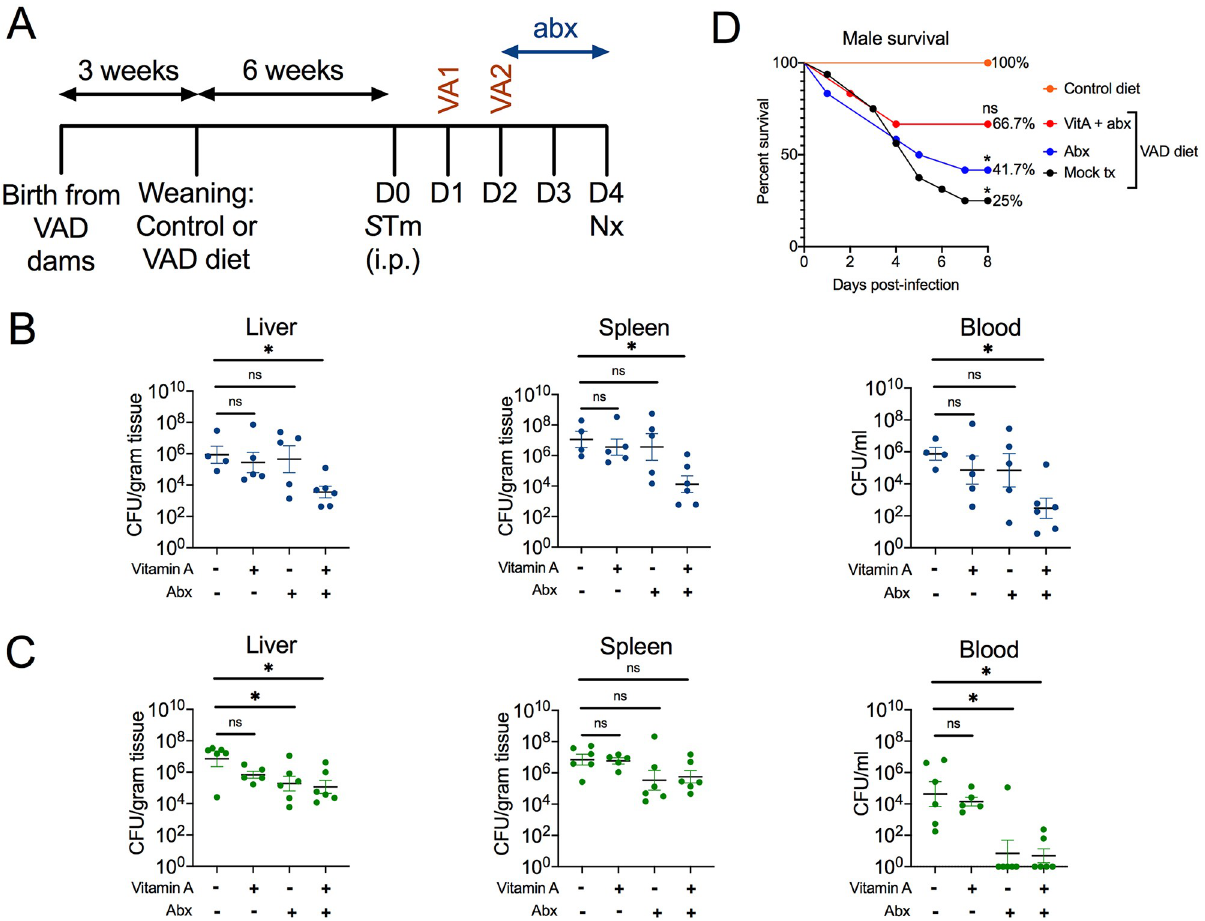
Fig 5. Co-treatment of vitamin A and antibiotics decreases systemic Salmonella burden and improves survival in VAD male mice. VAD and control Slc11a1 +/+ mice were generated and infected with multidrug resistant S . Typhimurium D23580 at 9 weeks of age. Mock-treated mice received 100 μ l of sterile PBS administered by oral gavage on day 1 and day 2 post-infection. Vitamin A-treated mice received 600 IU of retinyl palmitate in 100 μ l of sterile PBS administered by oral gavage on day 1 and day 2 post-infection and changed to control diet at day 1 post-infection. The antibiotic enrofloxacin (abx) was administered at day 2 post-infection in the drinking water at 0.05 mg/ml ( A ). Systemic burden of S . Typhimurium was characterized for VAD male ( B ) and VAD female ( C ) mice (n = 4–6) as CFU in liver, spleen and blood at necropsy 4 days post-infection. Data are reported as mean ± SEM. Significance was determined on log-transformed values with a Kruskal-Wallis test and Dunn’s multiple comparisons test ( � , p < 0.05; ns, not significant). ( D ) Percent survival for control and treated VAD male mice was assessed with an 8-day Kaplan-Meier survival curve (n = 6–16). An enrofloxacin concentration of 0.01 mg/ml was used in drinking water treatment, and oral gavage treatments were given as previously described. Significance was determined with pairwise comparisons between the control group and each other treatment group using a log-rank (Mantel-Cox) test ( � , p < 0.05; ns, not significant). Data from untreated controls are also included in Fig